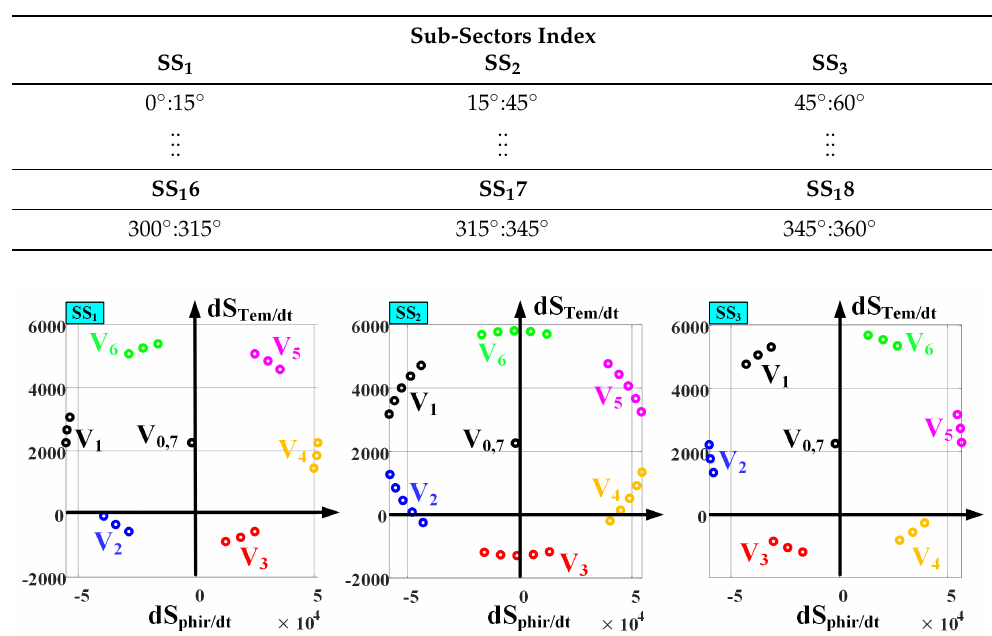
Table 2. Dividing the path of the rotor flux vector into (18) SSs.